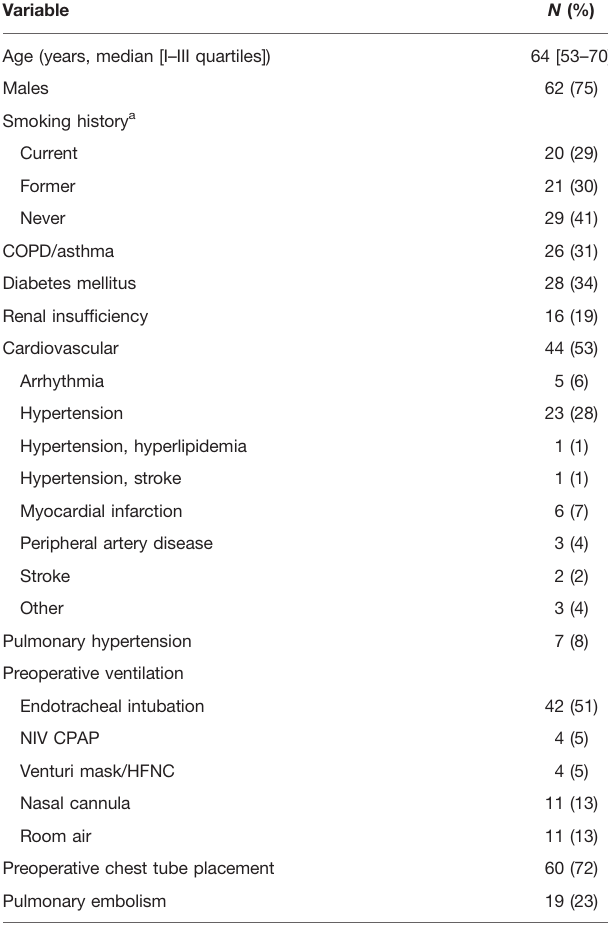
TABLE 1 | Anamnestic data of the whole population from 9 different worldwide thoracic surgery departments.